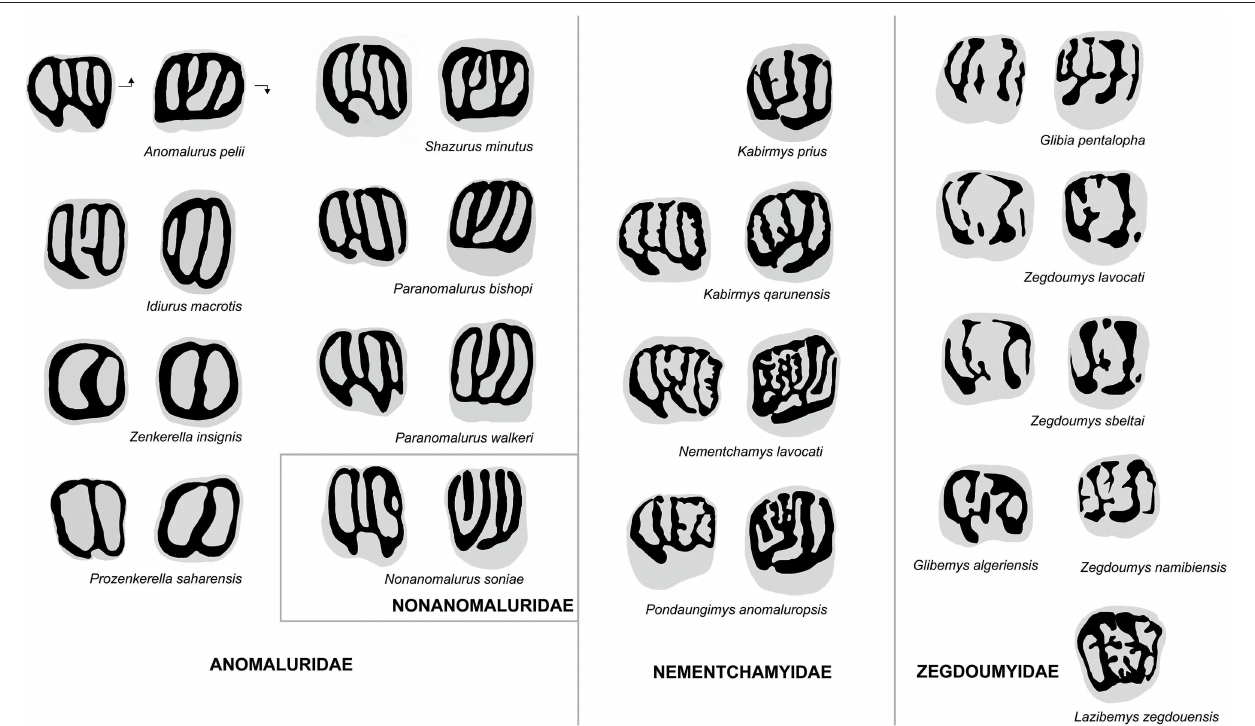
FIGURE 6 | Comparison of molar occlusal patterns in Anomaluridae, Nonanomaluridae, Nementchamyidae, and Zegdoumyidae. Lower molars on left, upper molars on right (not to scale). Arrows point mesially and lingually to indicate orientation.